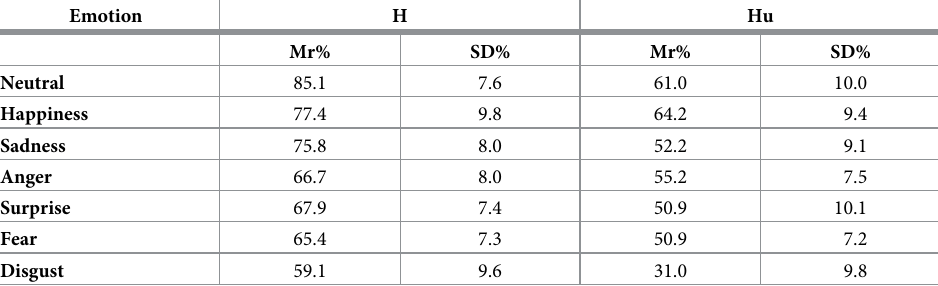
Table 3. Raw hit rates (H) and unbiased hit rates (Hu) for emotion categories: Phase 1.